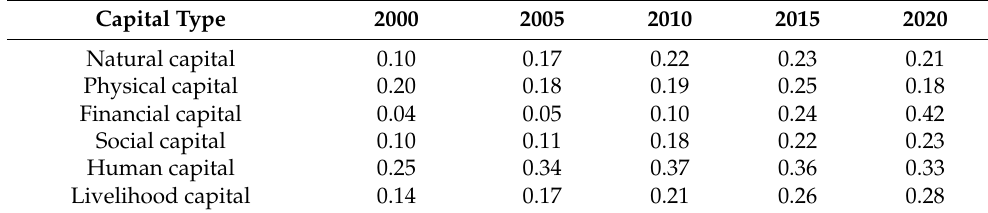
Table 7. Residents’ livelihood capital index in the ORTTR from 2000 to 2020.